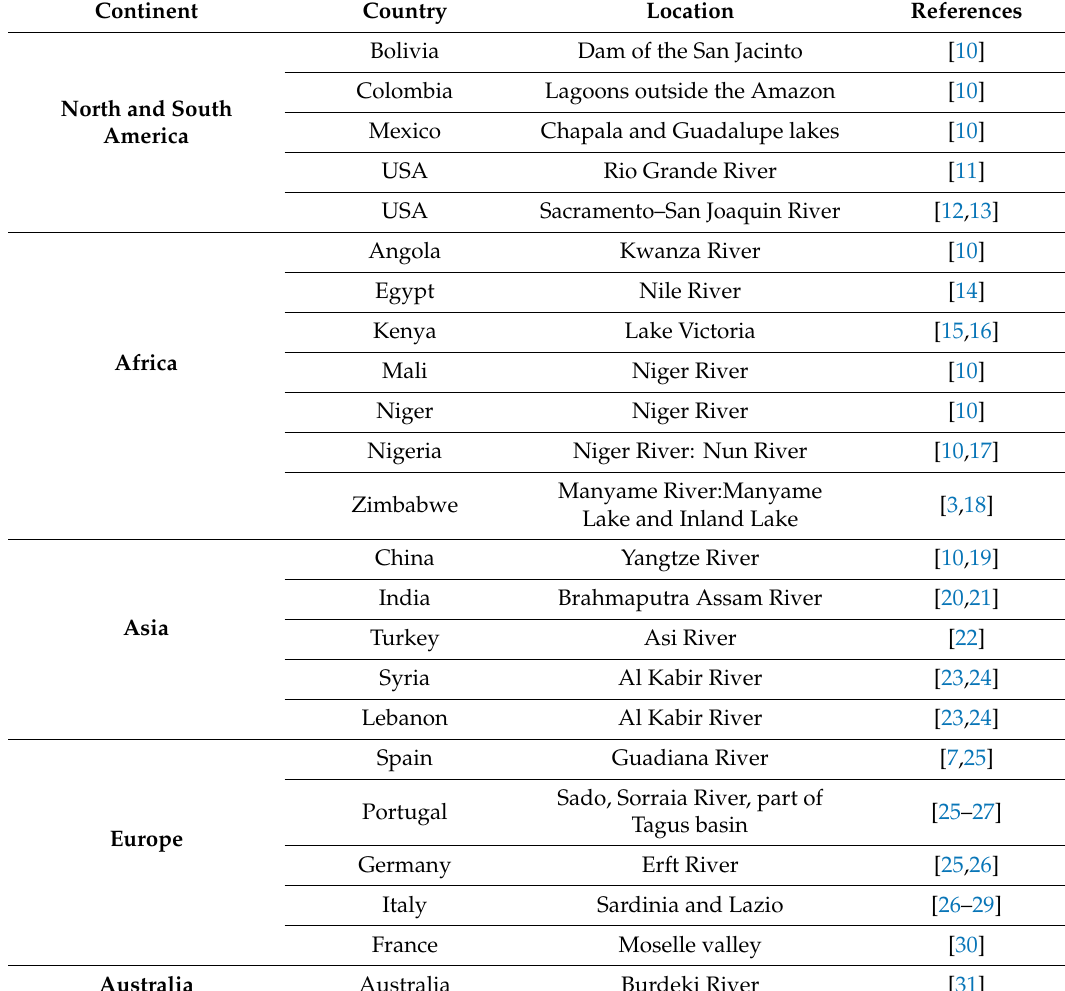
Table 1. Geographic distribution of Eichhornia crassipes (water